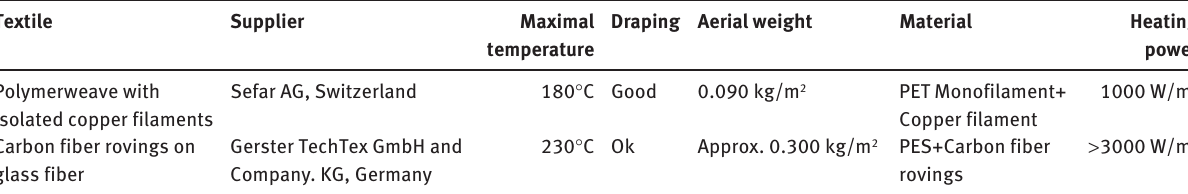
Table 3 Comparison of heating textiles. Textile